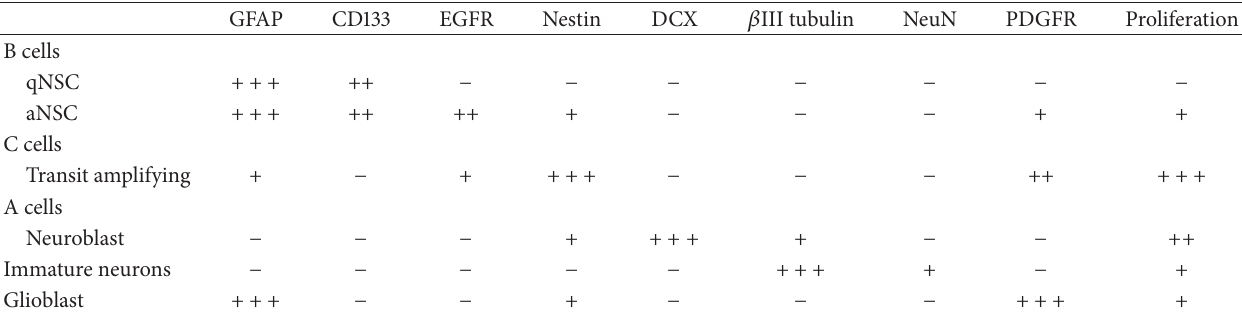
Table 1: SVZ neural stem cell characterization by cellular marker